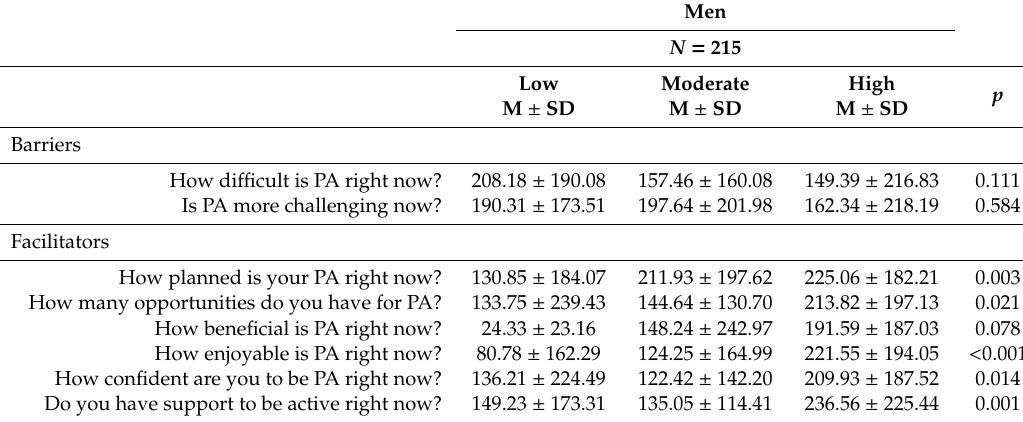
Table 5. ANOVA results for barriers and facilitators to physical activity for men and number of minutes of moderate–vigorous physical activity (min /